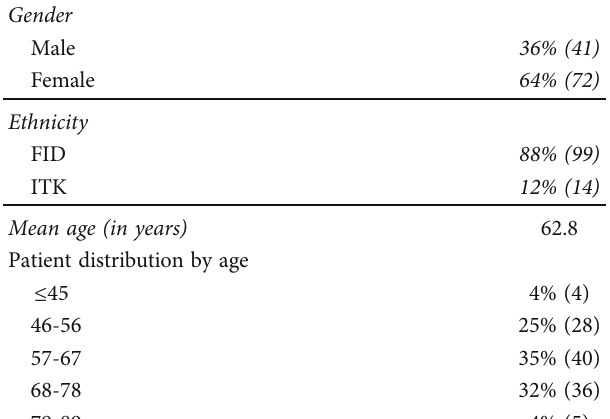
Table 2: Description of patient characteristics. Patient characteristics ( n = 113